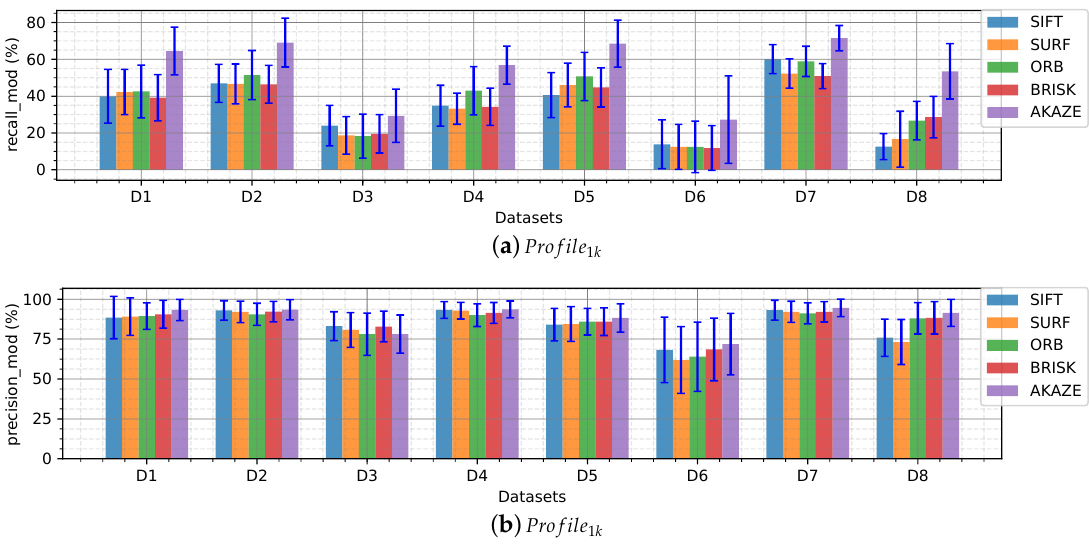
Figure 8. Inliers ratios per